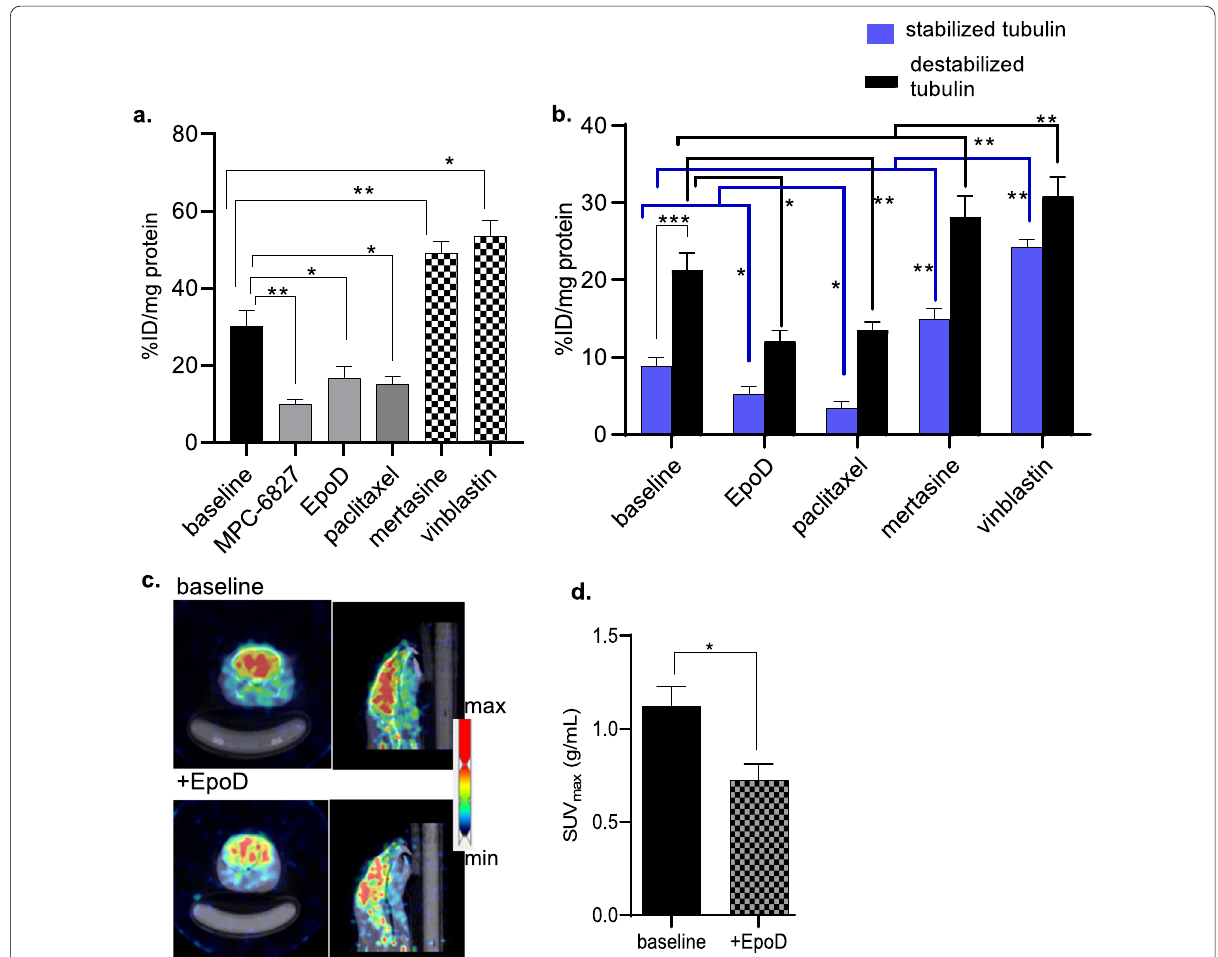
Fig. 1 [ 11 C]MPC-6827 a standard cell uptake b tubulin kit-based assay in vitro with different MT stabilizing and destabilizing agents after 30 min incubation ( n 6/group), using in SH-SY5Y cells; * p 0.05, ** p 0.004, *** p 0.00014; c representative axial and sagittal PET/CT brain images = ≤ = = from FVB/B6 wild type mice ( n 4) at baseline and after EpoD treatment with d their whole-brain SUV max after IV injection of [ 11 C]MPC-6827 = (3.7 0.05 MBq); * p 0.05, ** p ± ≤ =